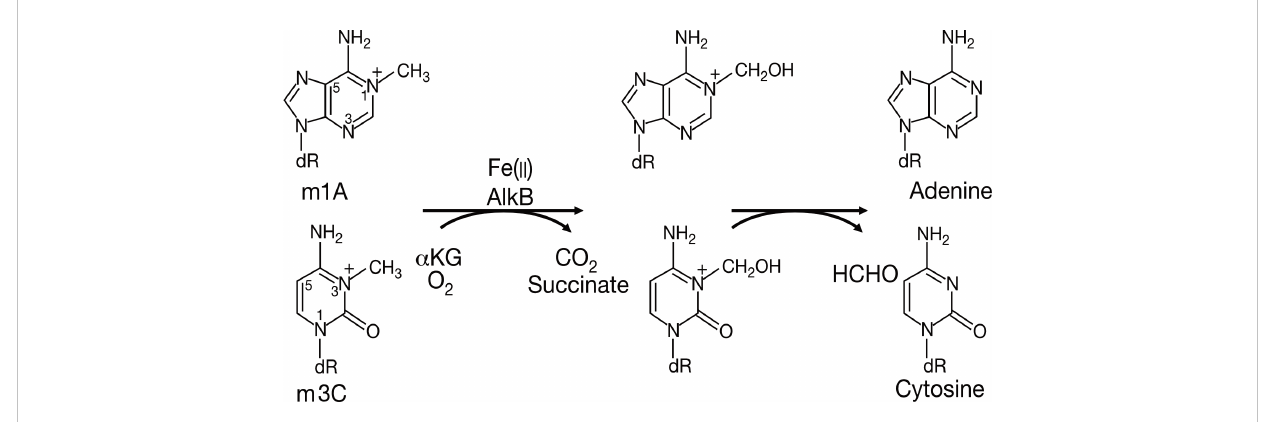
FIGURE 2 The primary demethylation reaction of AlkB in E.